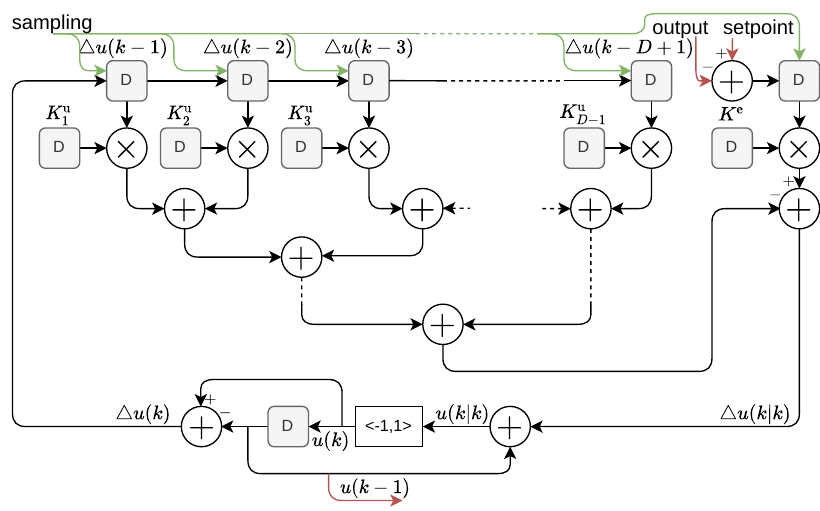
Figure 7. Improved design of FDMC with a logarithmic computational